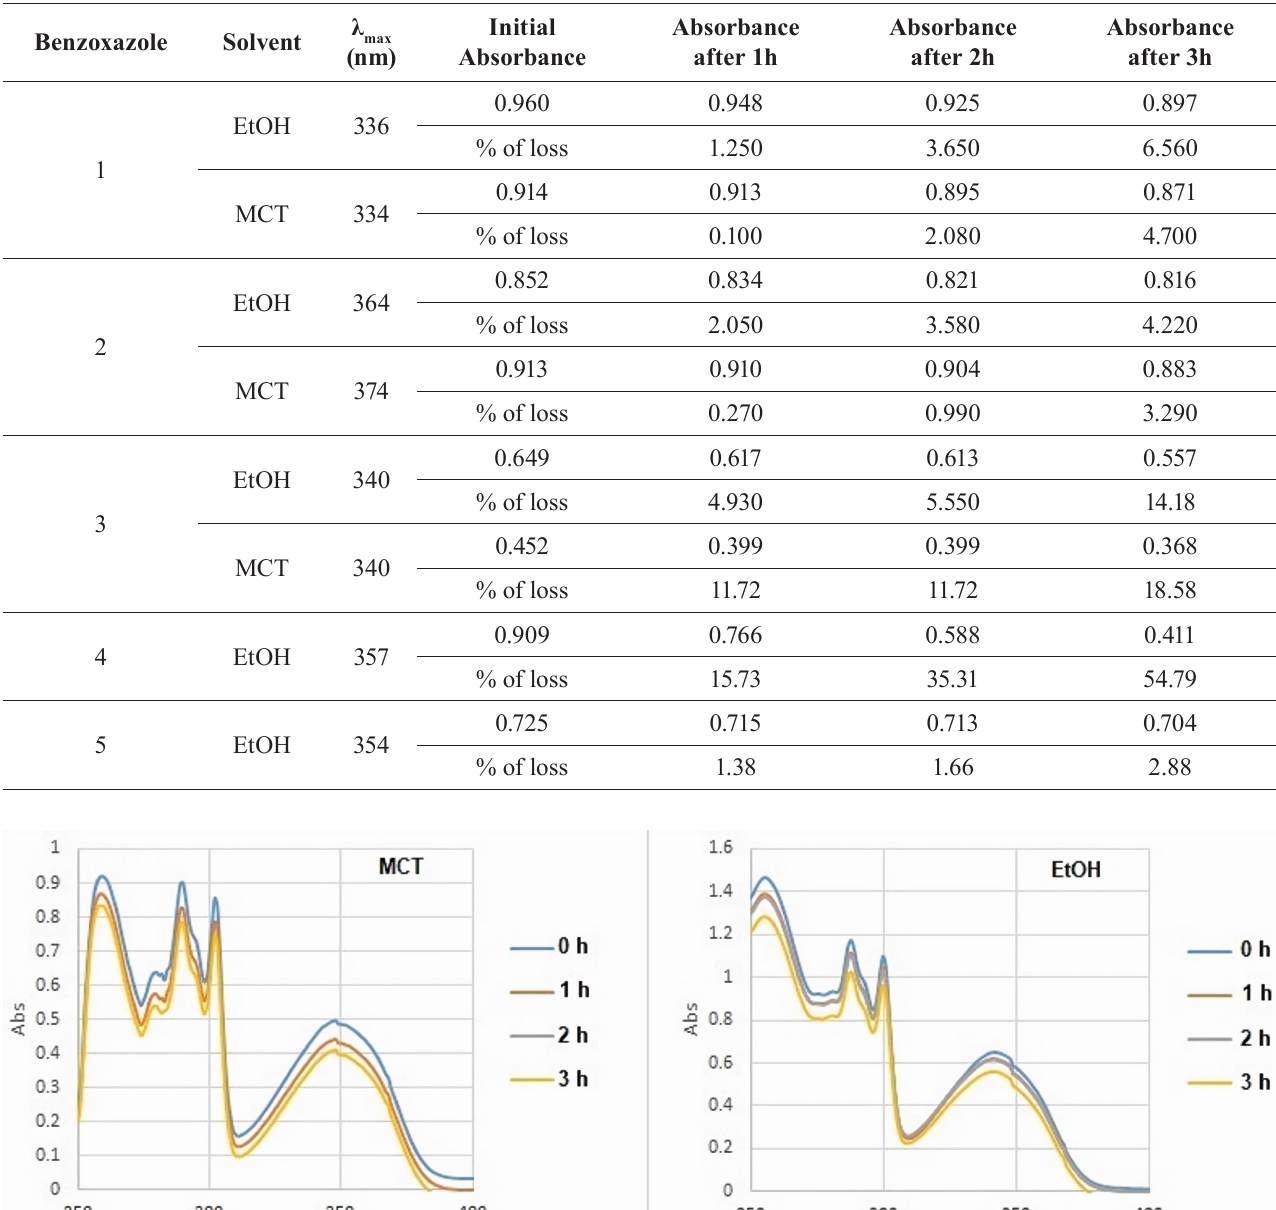
TABLE II - Absorbance of benzoxazoles 1-3 in EtOH and MCT, Avobenzona 4 and Uvinul® A Plus 5 in EtOH after irradiation